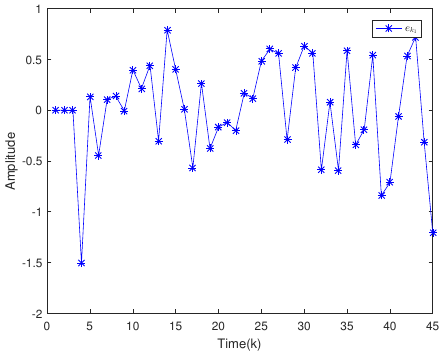
Figure 11. Filtering error e 1, k under the RAP